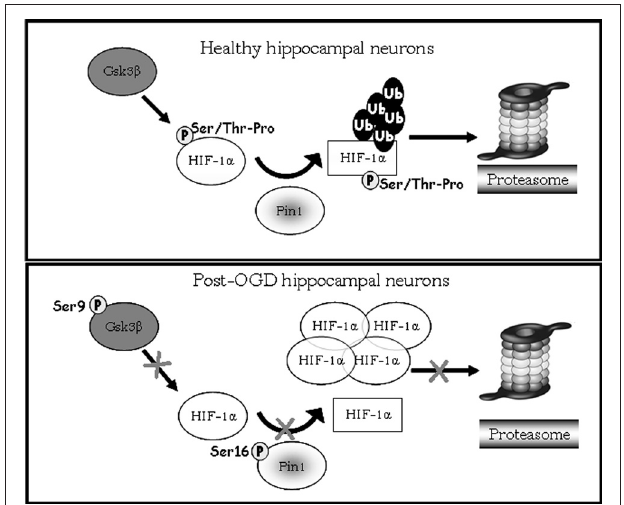
FIGURE 7 | Model showing HIF-1 α degradation pathway mediated by Pin1/Gsk-3 β . In healthy hippocampal neurons Gsk-3 β phosphorylates the HIF-1 α transcription factor on Ser/Thr-Pro motif potentially recognizible by Pin1. After phosphorylation Pin1 is able to recognize and bind the cis form of HIF-1 α (circle form), and catalyzes its isomerization to trans conformation (square). The E3 ligase complex having a structural preference for phosphorylated substrates in trans conformation to favors ubiquitination and the consequent degradation of the transcription factor via proteasome. In post-OGD neurons, instead, Gsk-3 β is inhibited by phosphorylation on Ser9, therefore HIF-1 α is not phosphorylated on Ser/Thr-Pro motif resulting unrecognizable by Pin1. Moreover Pin1 itself is inhibited by phosphorylation on Ser16, and its enzymatic activity is blocked leading to loss of HIF-1 α cis/trans isomerization. HIF-1 α is not more ubiquitinated and degradated via proteasome, accumulating in its cis